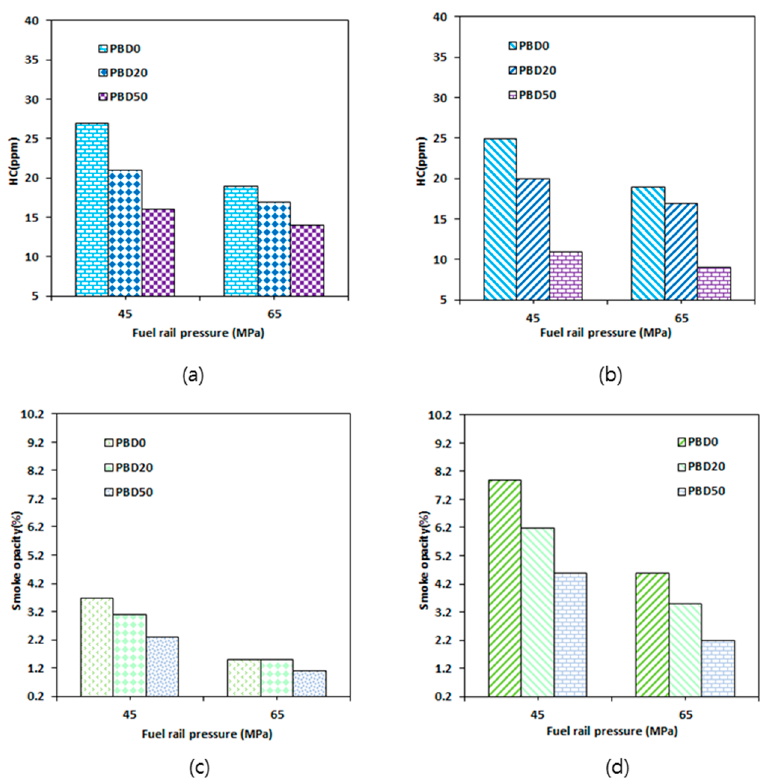
Figure 7. HC emissions in the exhaust gas for engine loads of ( a ) 50 Nm and ( b ) 100 Nm. PM in the exhaust gas for engine loads of ( c ) 50 Nm and ( d ) 100 Nm.